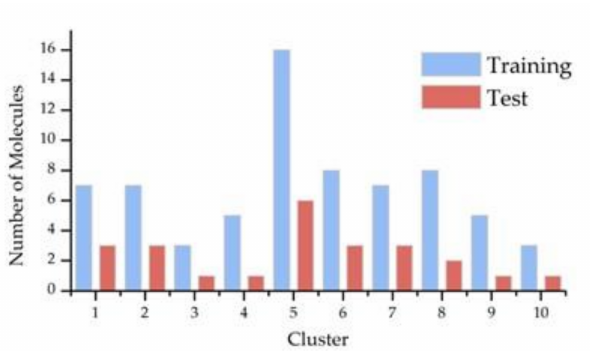
Figure 1. The dataset was divided in 10 clusters employing Ward’s method to split into blue bars (training 74%) and red bars (test set 26%).